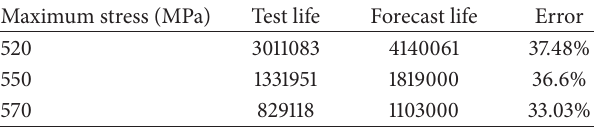
Table 1: The fatigue life prediction results of smooth